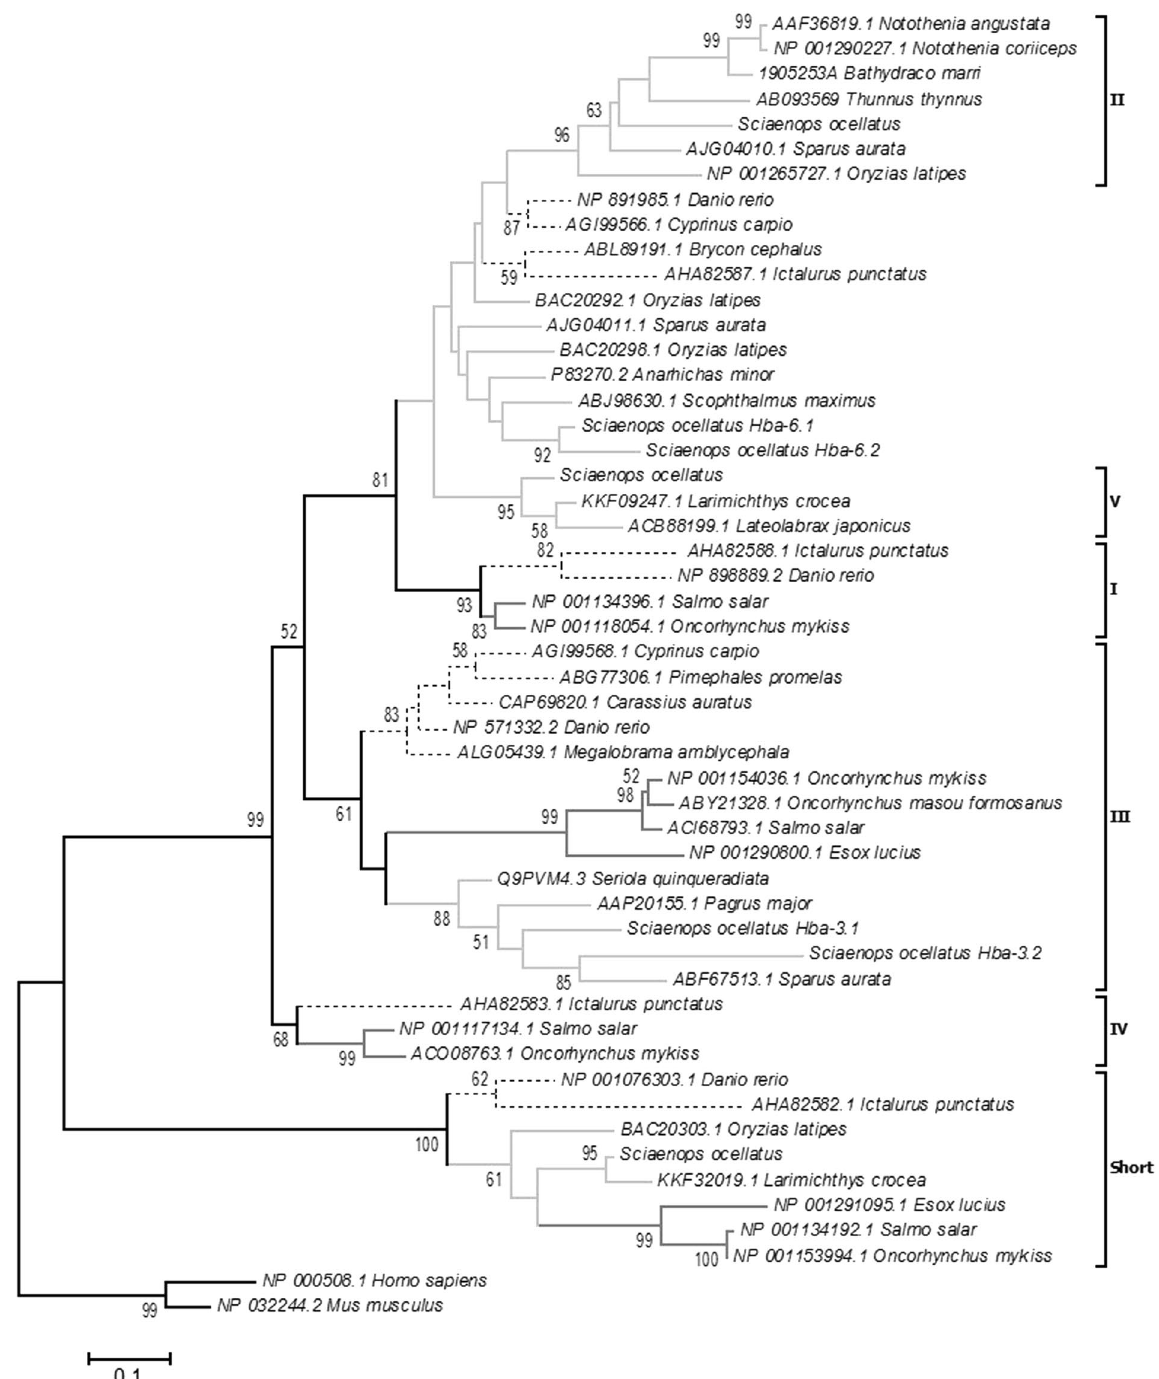
Figure 1. Maximum likelihood analysis showing the phylogenetic relationship for Hb α subunits in teleosts. Different colors represent the species’ respective superorder: light gray = Acanthopterygii; black dotted = Otocephala; dark gray = Protacanthopterygii. GenBank accession numbers are provided within the respective species designations. Numbers represent node bootstrap support. Values below 50% are not shown, which designates a poorly supported